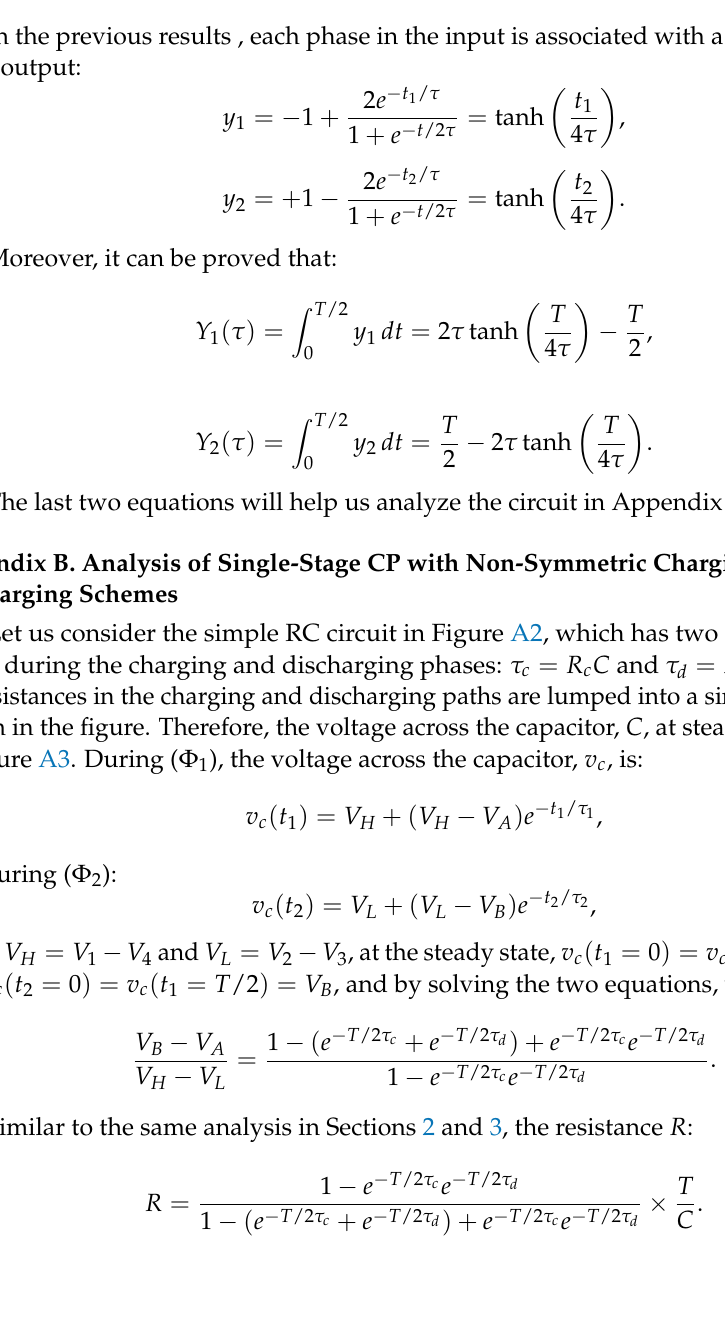
Figure A1. MATLAB Simulation showing the transient and steady-state response of H ( s ) for an input square wave, x ( t )